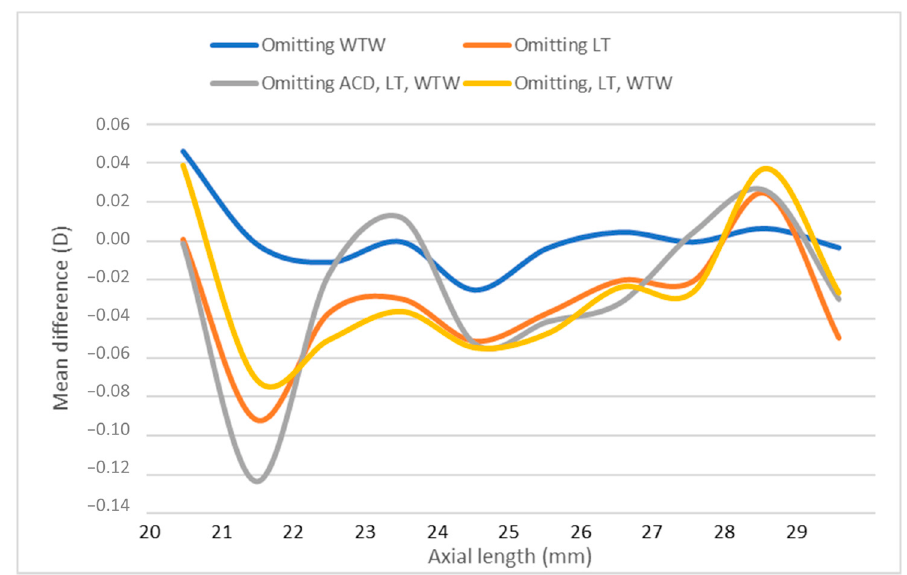
Figure 4. Smooth line graph of non-absolute difference in IOL power between selected partial and all data biometry in relation to axial length. ACD; anterior chamber depth, D; diopters, IOL; intra- ocular, LT; lens thickness, WTW; white-to-white.